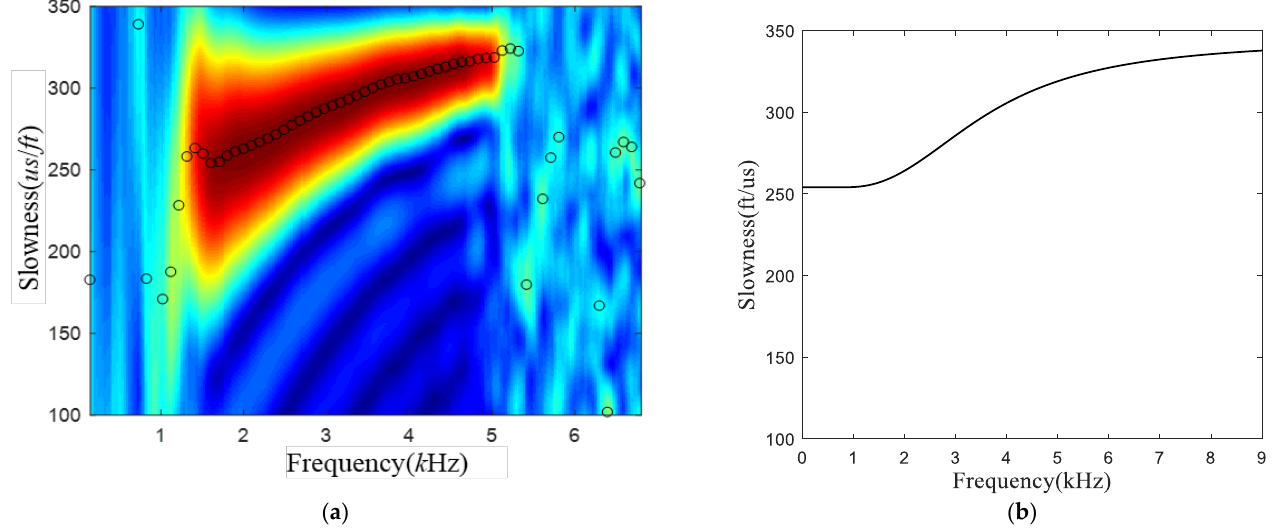
Figure 3. ( a ) Dispersion analysis by the weighted spectral semblance method and ( b ) the fitting results.